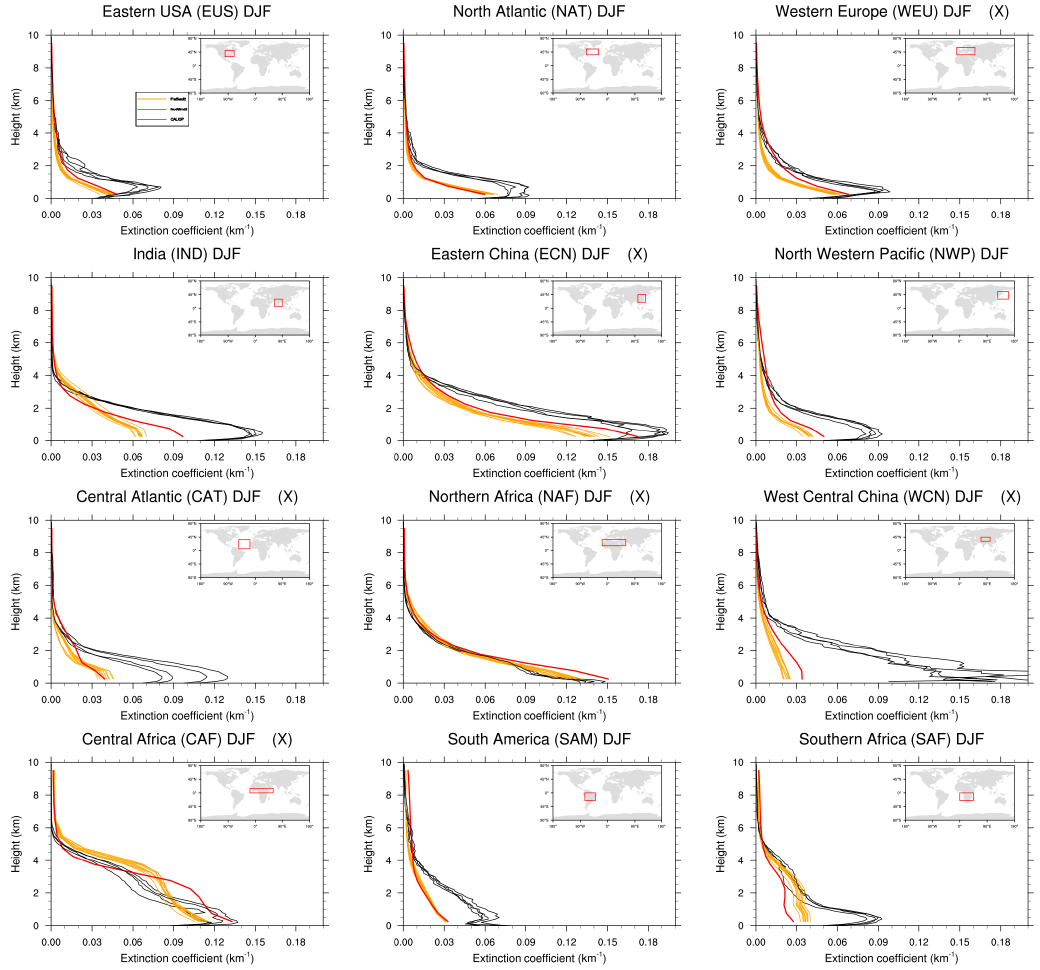
Figure 16. Mean DJF vertical profiles of extinction coefficients (km − 1 ) for total aerosols for the FreSimd2 simulation (orange lines) for 2004 (repeated 10 times), the NudSimd2 simulation (red line), and for individual years of the CALIOP 3-D product (black lines), over 12 regions of the globe, as in Koffi et al. (2012) (see in top right corners of individual figures). (X) indicates regions also presented in Fig.